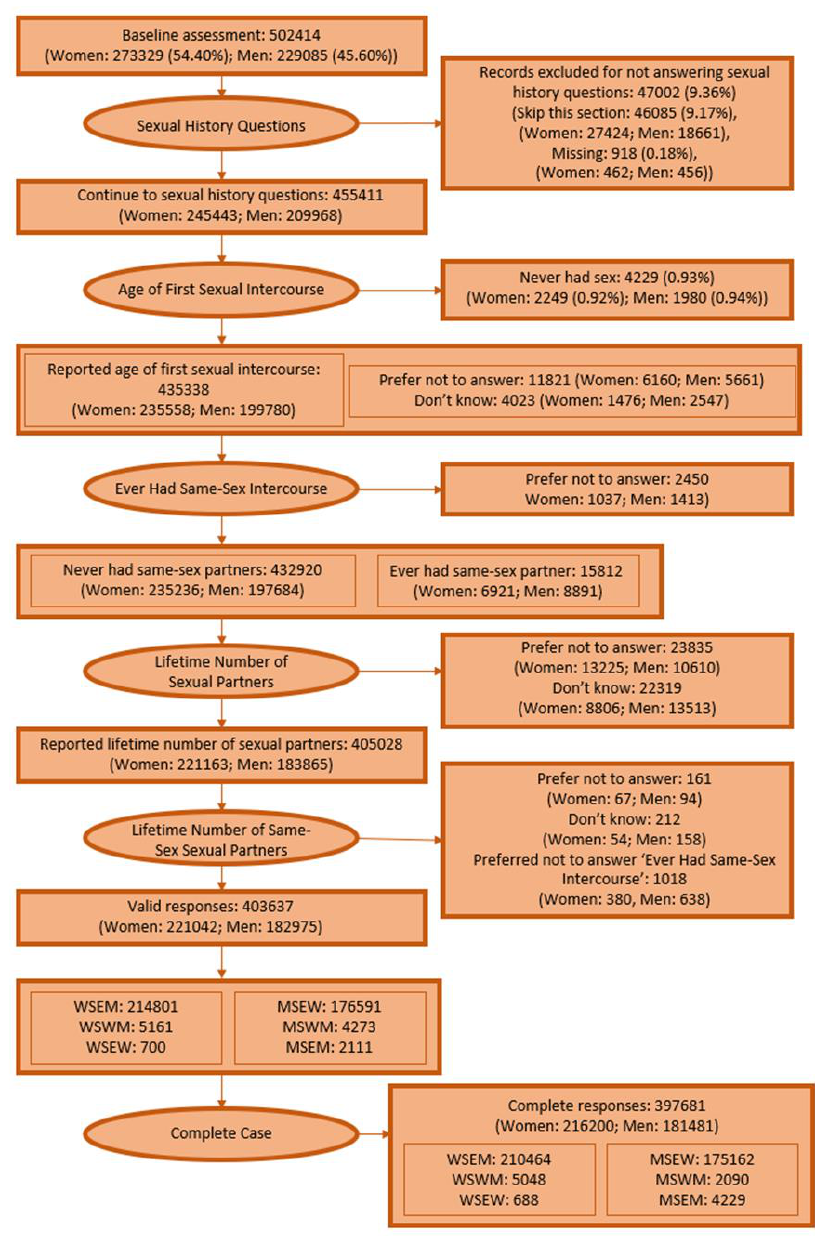
Figure A1. Flowchart of analysis